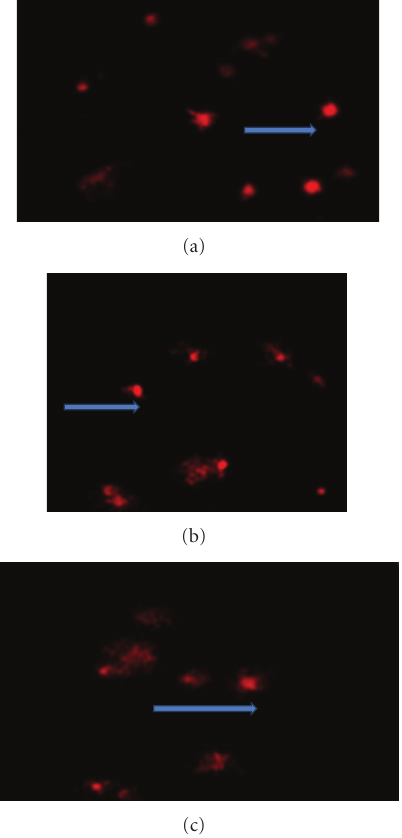
Figure 3: Evaluation of DNA damage induced by 50Hz and 0.5 mT MF for 30 days 24h/day in the brain cells of newborn rats processed by comet assay. (a) represents cells without visible DNA damage type (0), (b) represents cells with symptom of increasing DNA damage types (1, 2, and 3), and (c) represents cells with a major DNA damage (type 4).